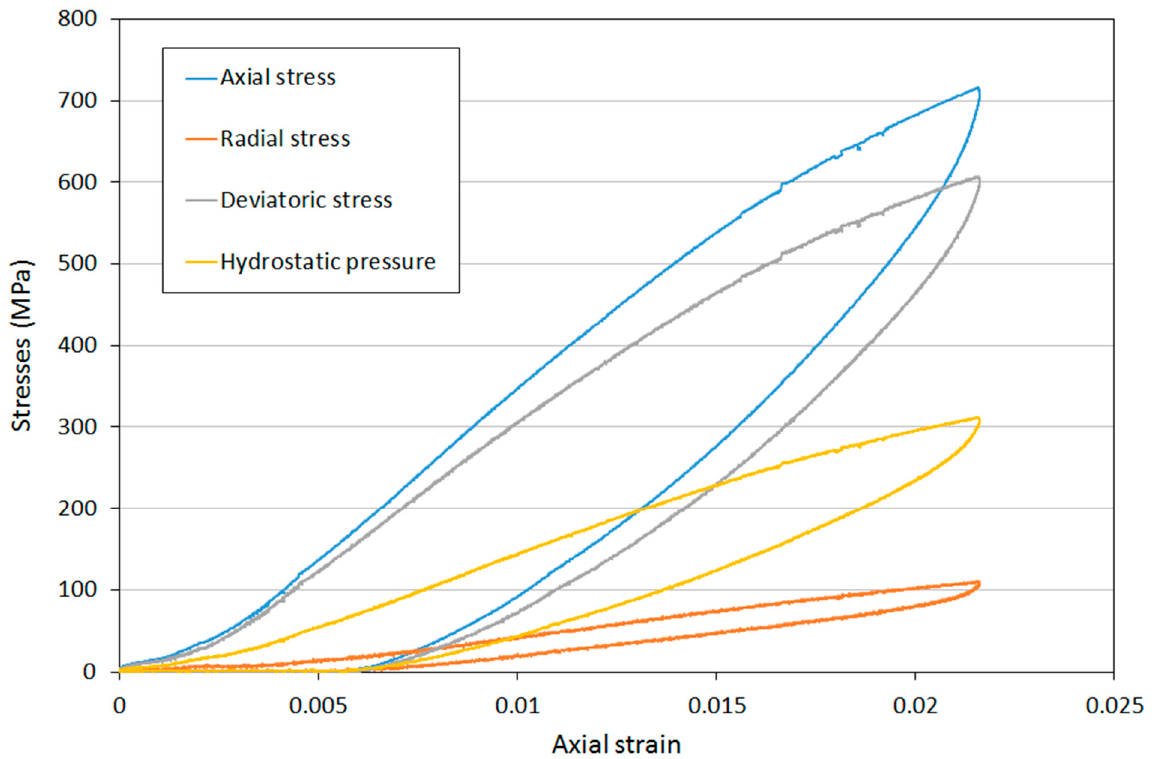
Figure 9. Stress versus axial strain in sandstone sample #1 (loading–unloading).